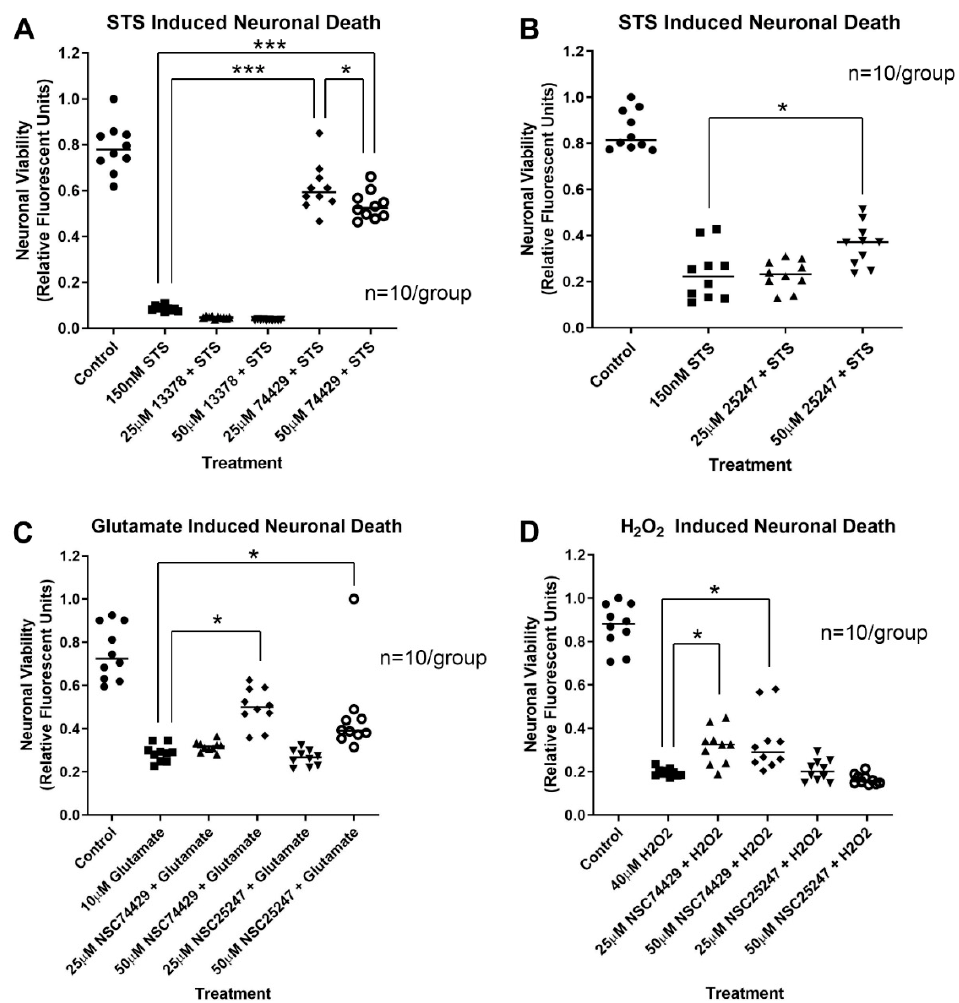
Figure 2. Neuroprotective Efficacy of NSC13378, NSC25247, and NSC74429 in Cultured Primary Rat Cortical Neurons. Neurons were injured on day in vitro (DIV) 9 and treated with vehicle or NSC compounds. ( A ) A scatter plot showing 24 h viability in staurosporine injured neurons treated with NSC13378 or NSC74429. ( B ) A scatter plot showing 24 h viability in staurosporine injured neurons treated with NSC25247. ( C ) A scatter plot showing 24 h viability in glutamate injured neurons treated with NSC25247 or NSC74429. ( D ) A scatter plot showing 24 h viability in hydrogen peroxide injured neurons treated with NSC25247 or NSC74429. All groups include n = 10/group. Data were analyzed by ANOVA and post hoc significance was detected using the Newman-Keuls multiple comparison test. Data were significant at p < 0.05. (*) = p < 0.05, (***) = p < 0.001.